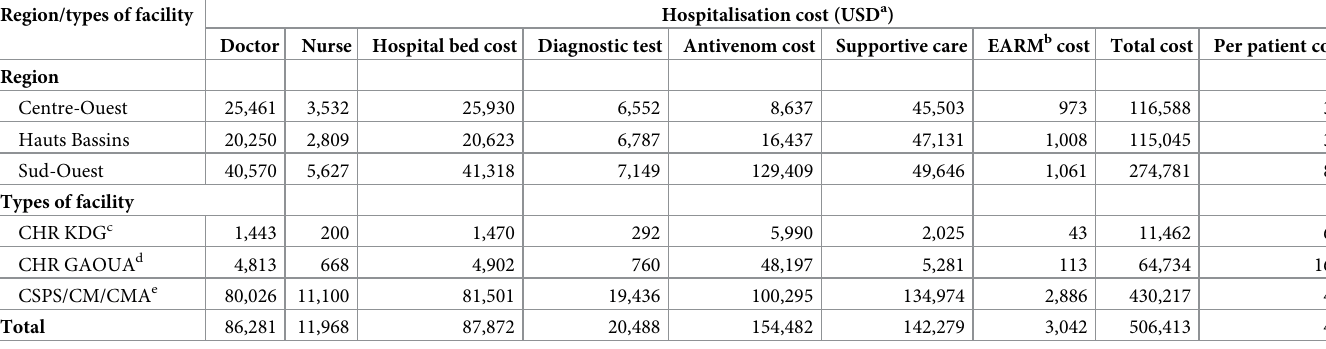
Table 5. Annual cost (USD) of hospital management of snakebite patients by region and types of health